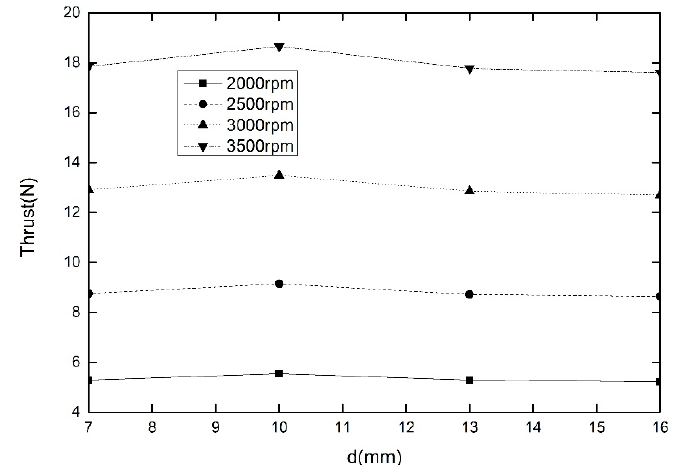
Figure 20. Effect of distance between propellers on the thrust of the ducted fan UAV.